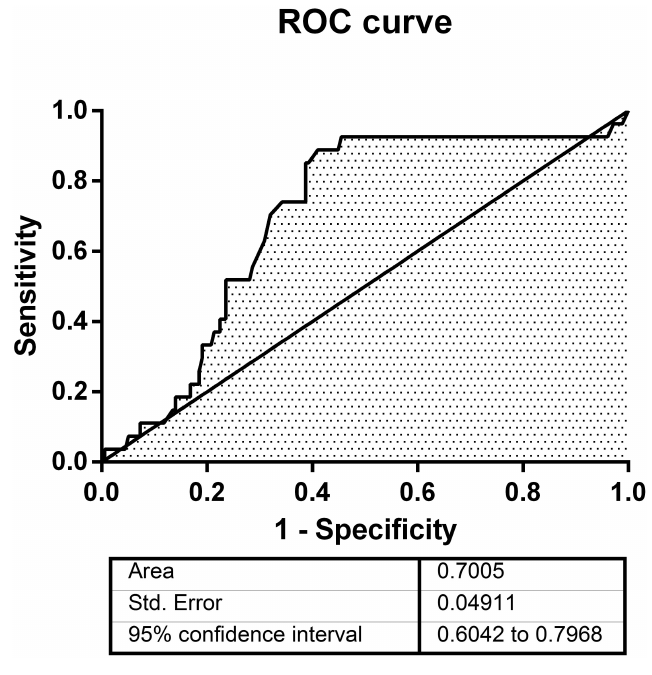
Figure 4. ROC curve of lesion volume.